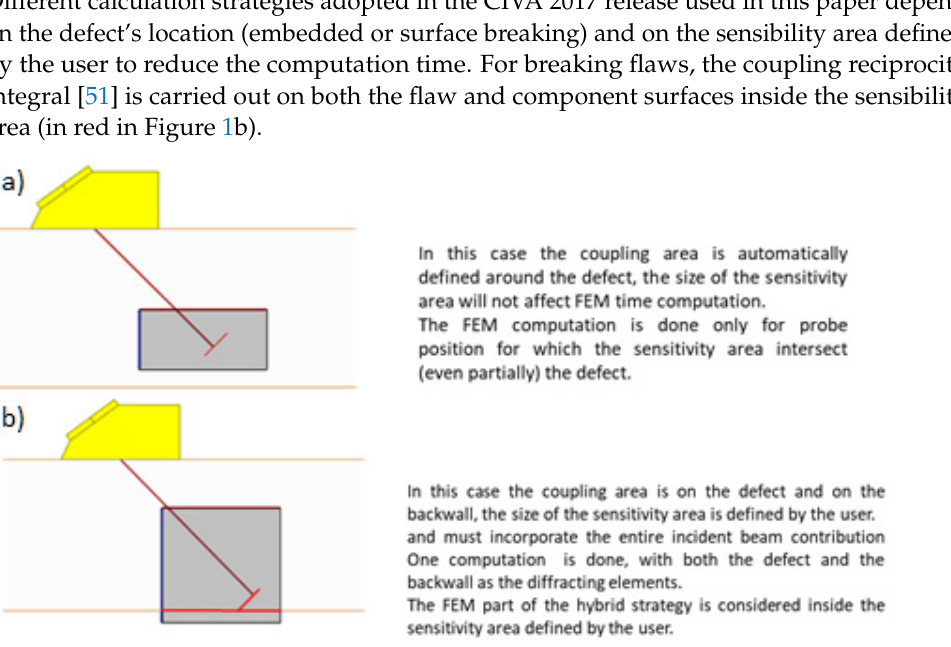
( b ) breaking Figure 1. Different coupling strategies used in the CIVA hybrid FEM model for ( a ) embedded and ( b ) breaking cracks.